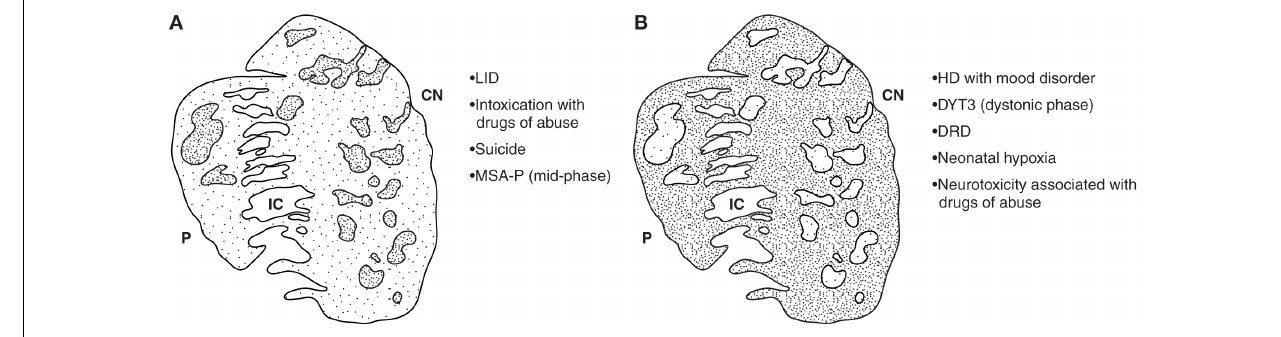
opposite compartment.The diagram is based on a cross-section through the striatum of an adult human, immunostained for choline acetyltransferase. Medial is to the right. CN, caudate nucleus; P, putamen; IC, internal capsule; LID, L-DOPA-induced dyskinesia; MSA-P, multiple system atrophy with parkinsonian features; HD, Huntington’s disease; DYT3, X-linked dystonia-parkinsonism; DRD, dopamine-responsive dystonia